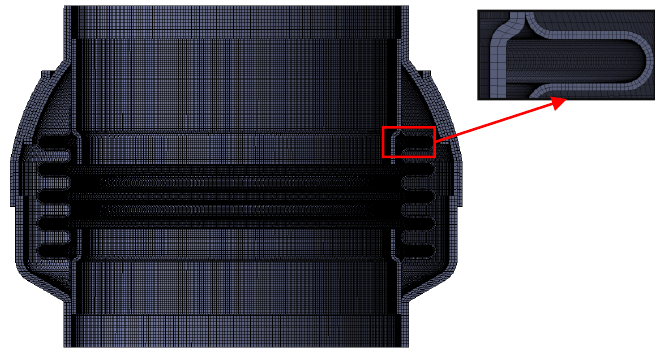
Figure 9. FE meshed model.